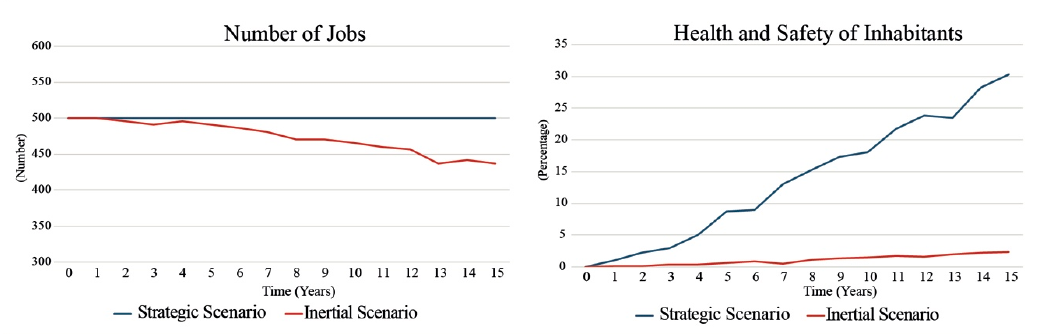
Figure 12. Simulation of the evolution of environmental variables over time (Datola et al., 2019).